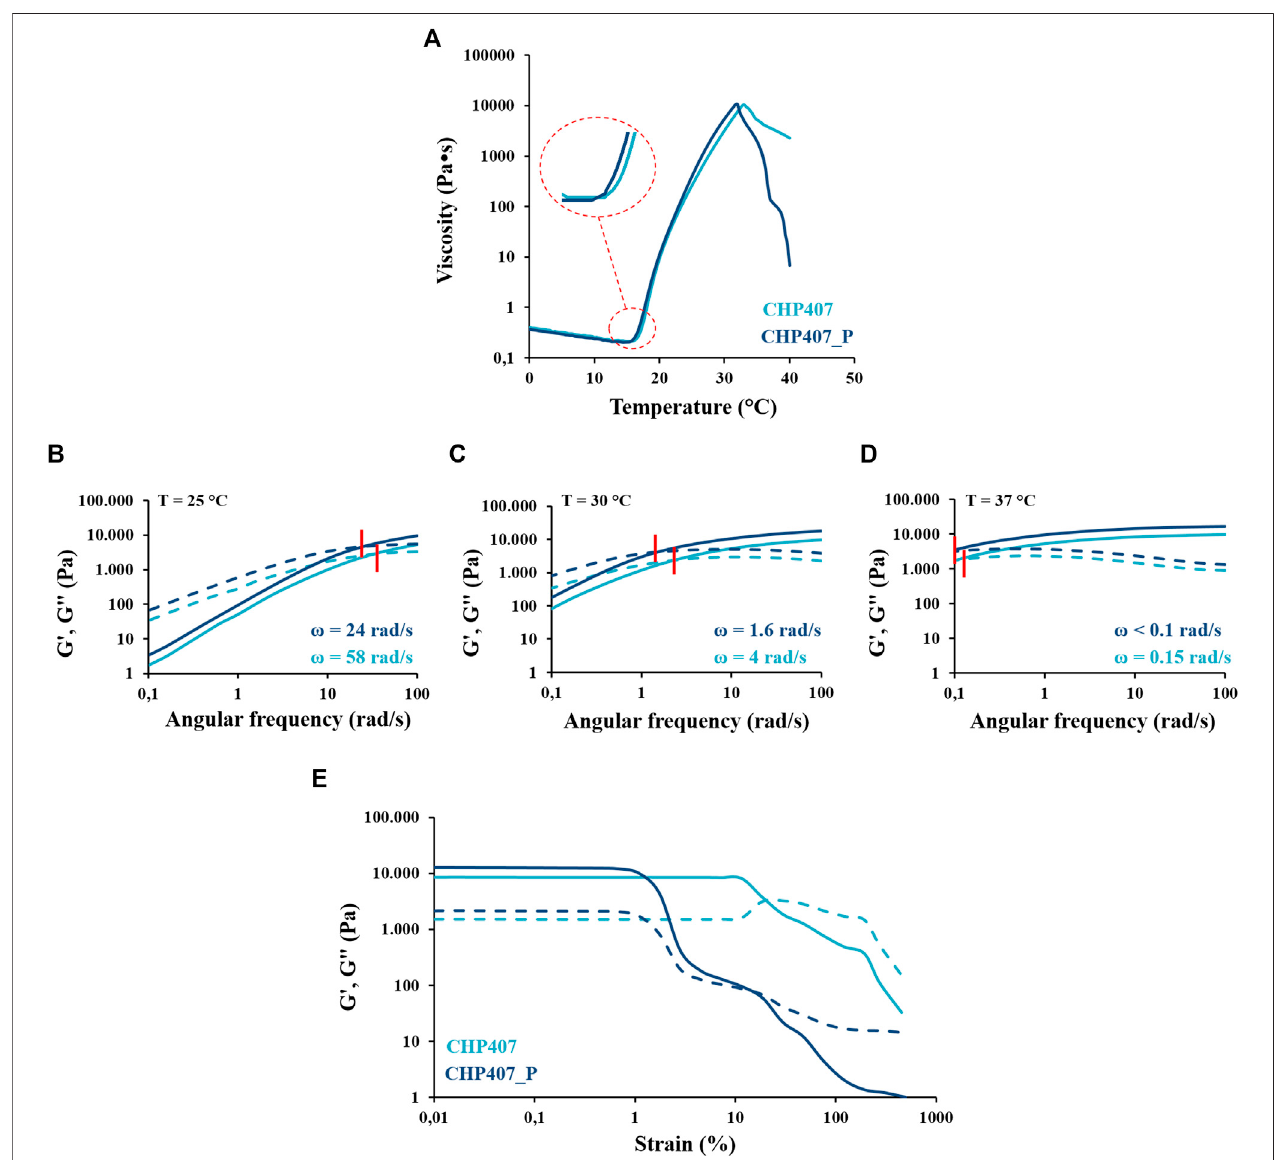
FIGURE 7 | (A) Viscosity pro fi les vs. temperature during sol-to-gel transition through temperature ramp test performed on CHP407 (light blue) and CHP407_P (dark blue) solutions (15% w/V concentration). (B – D) Frequency sweep test: storage (G ’– continuous line) and loss (G ”– dashed line) moduli registered for CHP407 (G ’ , G ”– light blue) and CHP407_P (G ’ , G ”– dark blue) gels at 25 ° C, 30 ° C, and 37 ° C. Red bars mark G ’ /G ″ crossover point ( ω ). (E) Strain sweep test: storage (G ’– continuous line) and loss (G ”– dashed line) moduliregistered asa function of applied deformation in the range 0.01% – 500%for CHP407 (light blue) and CHP407_P (dark blue) sol-gel systems at 37 °